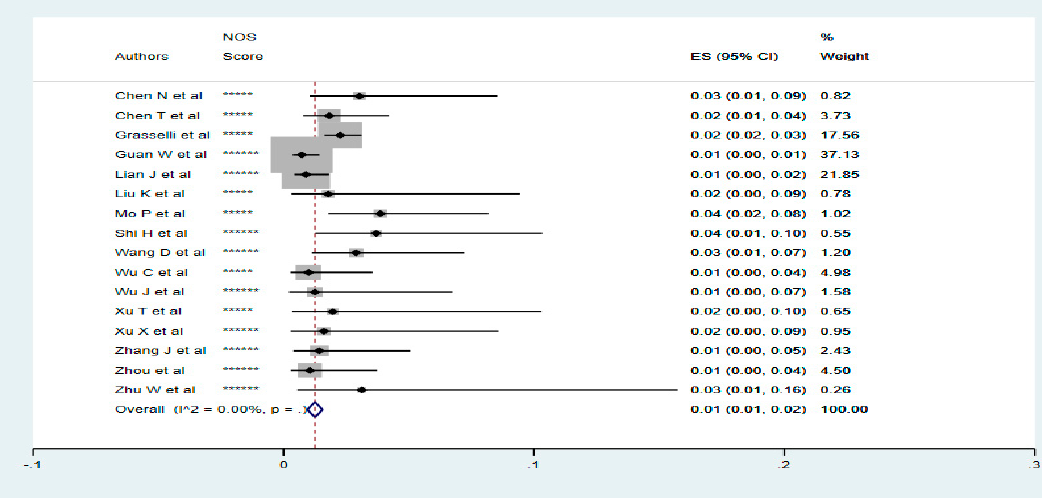
Figure 2. Pooled prevalence of patients with chronic renal diseases diagnosed with COVID-19. The red dotted line represents the overall effect size of the studies (0.01). The lateral edges of the blue diamond represent the limits of the 95% confidence intervals (0.01, 0.02). ES = Effect Size, NOS = Newcastle-Ottawa Score.